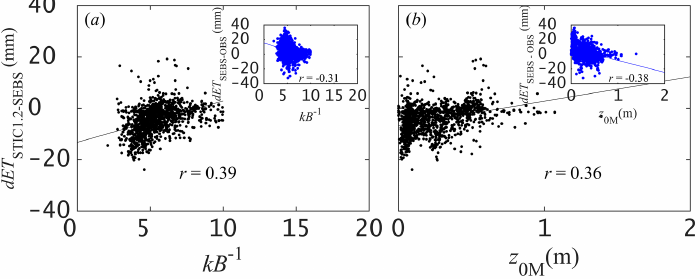
Figure 13. Scatter plots of the residual differences in cumulative 8-day ET estimates from STIC1.2 and SEBS and the residual errors from SEBS (vs. the observations) against kB − 1 and z 0M . Pearson correlation coefficient, r ( p -value was < 0.005 for all relationships shown above), are also shown in each plot. The z 0M was estimated from NDVI (van der Kwast et al., 2009) using no prior canopy height